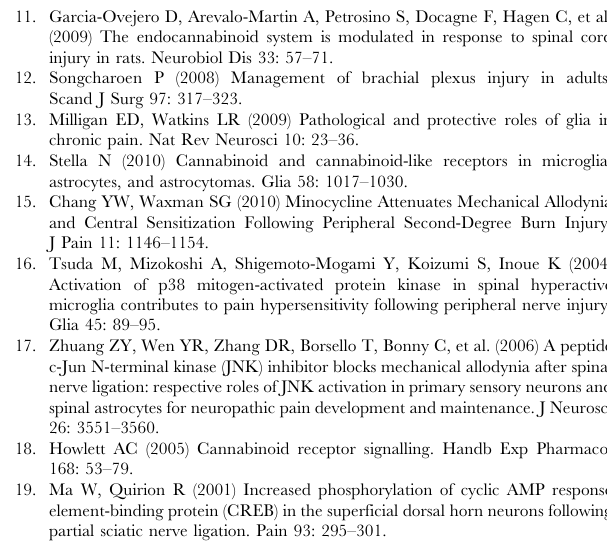
(TIF) Figure S4 Effect of treatment with selective antisense oligodeoxinucleotide (AS-ODN) on CB 1 and CB 2 receptor expression in the spinal cord of mice. Immunostaining of activated of CB 1 and CB 2 receptors in operated (Op) mice received an i.t. injection twice daily of mismatch (MM) AS-ODN (12.5 m g/site), CB 1 AS-ODN (12.5 m g/site) or CB 2 AS-ODN (12.5 m g/site) on the 5 th and 30 th day after brachial plexus avulsion (BPA). The scale bar corresponds to 50 m m and applies throughout. Figure S5 Effect of cannabinoid agonist on the expres- sion of glial cells, MAP kinases and transcription factors in the dorsal horn of the spinal cord after brachial plexus avulsion (BPA) in mice. Immunostaining of activated microglia (Iba-1), astrocytes (GFAP), phospho-p38 (p-p38) and phospho-JNK (p-JNK) MAP kinases, phospho-CREB (p-CREB) and phospho-p65 NF- k B (p-p65) transcription factors in operated mice treated with vehicle (10 ml/kg, i.p.), acute (once) or long- term (five times) treatment with WIN 55,212-2 (3 mg/kg, i.p.) on the 5 th and 30 th days after BPA. The scale bar corresponds to 50 m m and applies throughout. JNK: c-Jun N-terminal kinase; CREB: cAMP response element-binding protein; p65 NF- k B: